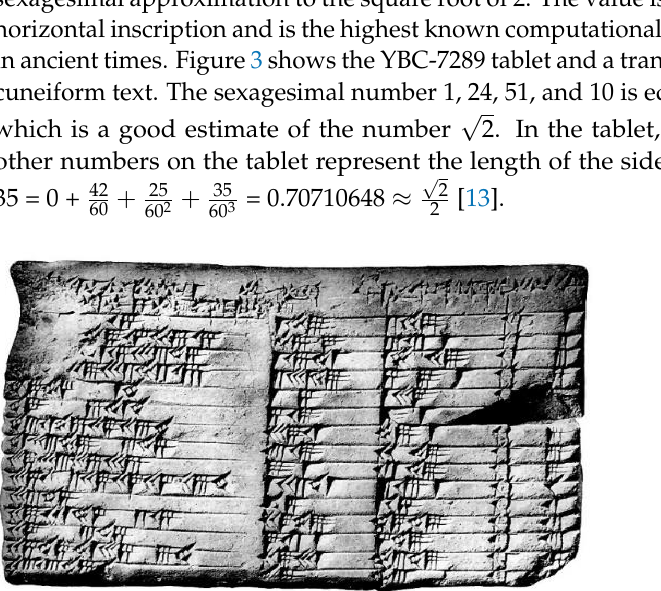
Figure 2. Plimpton 322 is a Babylonian clay tablet with an illustration of Babylonian mathematics [14].